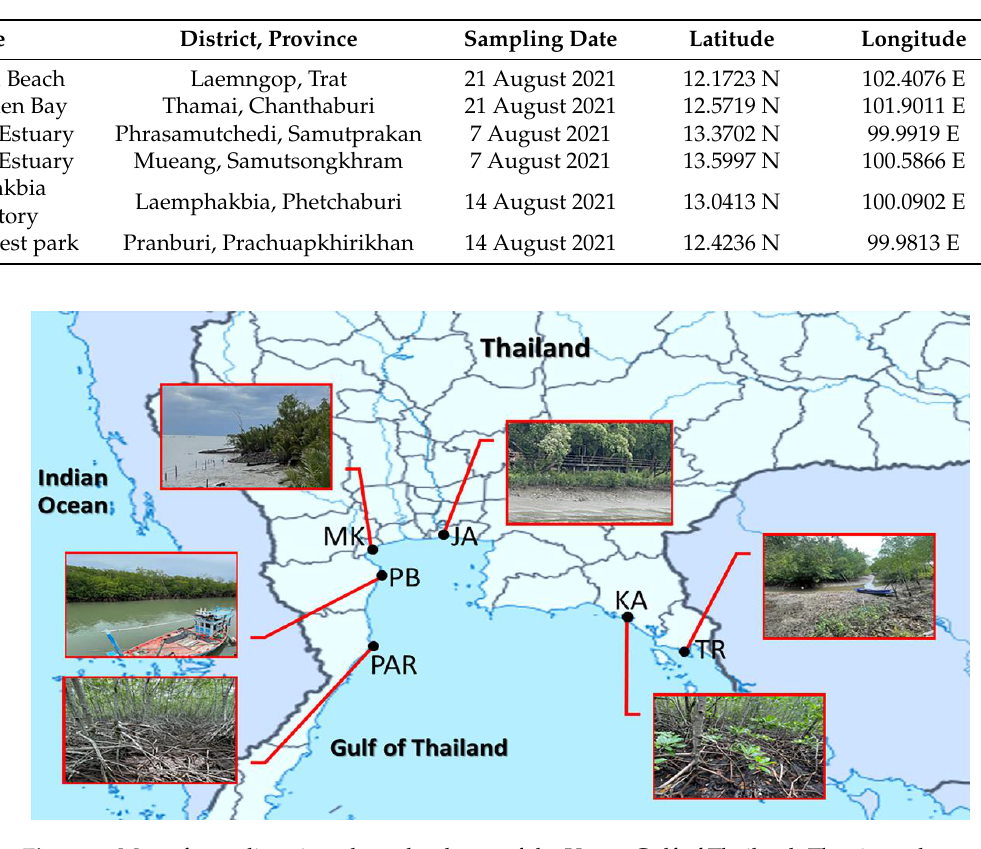
Table 1. Mangrove forest sites, geographical locations, and sampling dates.